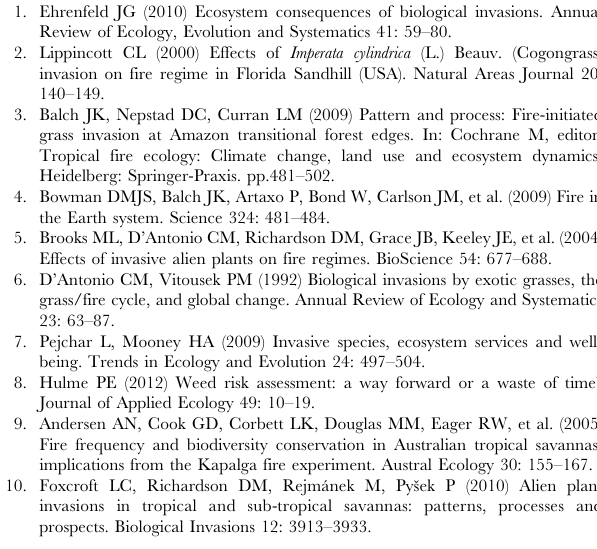
Table S1 Comparison of fire costs. Comparison of costs (in 2010 dollar values) from six paired fires in (a) native grass (prior to A. gayanus grass invasion) and (b) A. gayanus fuelled fires. For (b), the cover of A. gayanus in the burnt area was provided by fire fighters and reported for each. Paired fires were selected based on the close proximity of ignition therefore the staff and resource response would be expected to be similar over time. Grass Fire Unit is standard 4WD with basic fire fighting equipment. Enhanced vehicle has additional communications and fire-fighting capabil- ities. Private Vehicle is the rate paid for call out of staff private vehicle. Helicopter, grader, loader and water tanker rates vary slightly depending on the contractor available for the fire. Two different helicopters used during this fire, giving a different rate per